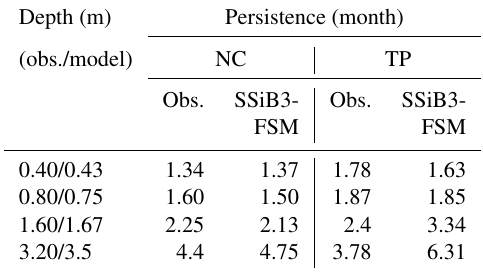
Table 3. The persistence of soil temperature at different soil depths over the TP and NC by SSiB3-FSM and the